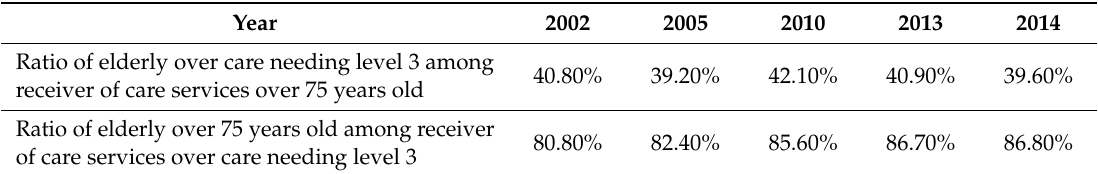
Table 4. Ratio of persons among those age 75 years or over who were receiving care at Level 3 or above. Year 2002 2005 2010 2013